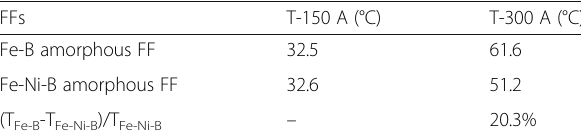
Table. 2 The temperatures of FFs in 2000 s under different output